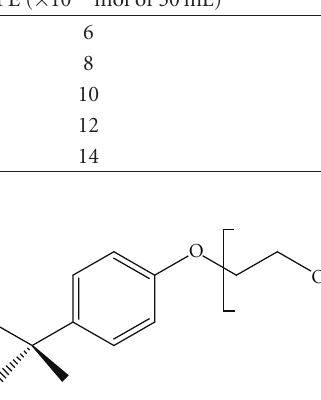
Figure 1: The molecular structure of